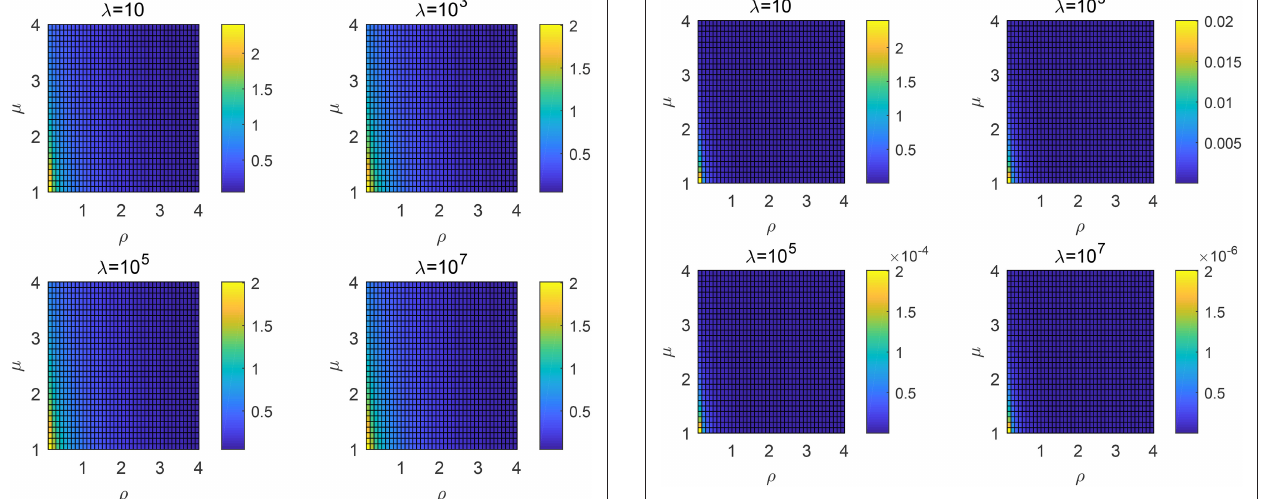
FIGURE 4 | Searching efficiency ηλ for different order µ and ρ : the non-destructive case with different λ .